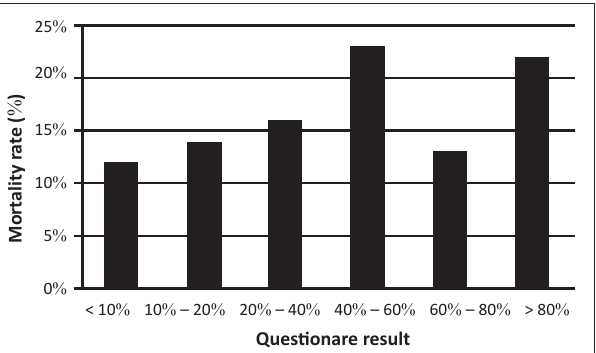
FIGURE 1: Mortality rate reported in the 2012